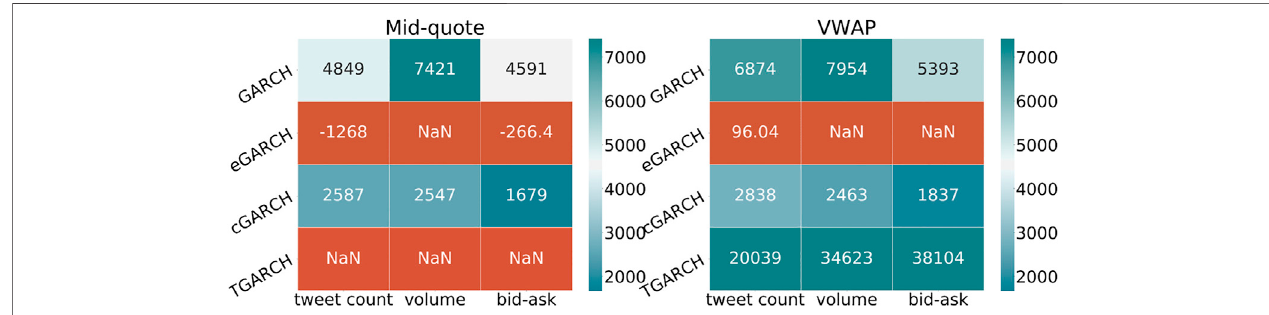
Frontiers in Physics |